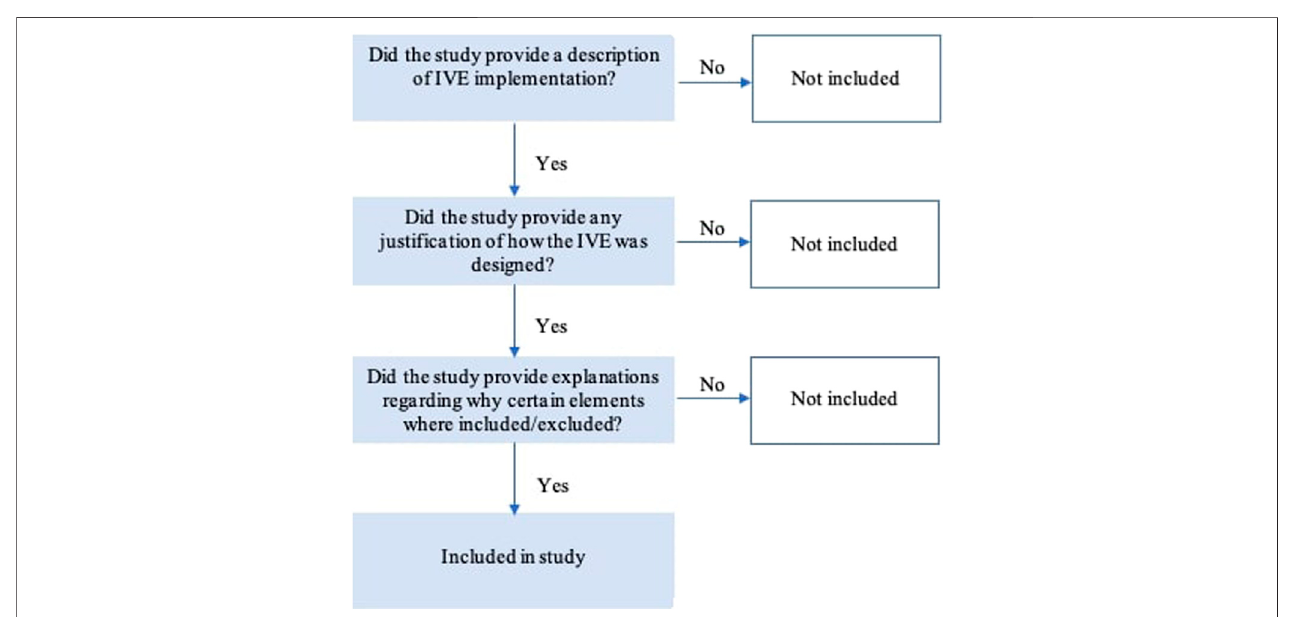
FIGURE 3 | A yes/no fl owchart to decide if a study provided suf fi cient details on how it designed and set up the IVE.